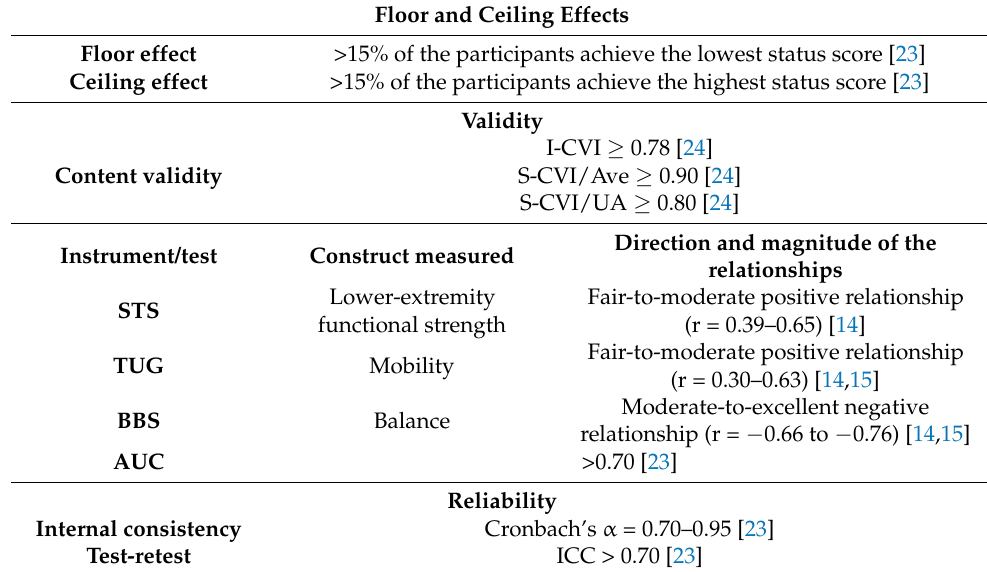
Table 1. A priori hypotheses for testing the psychometric properties of the Arabic